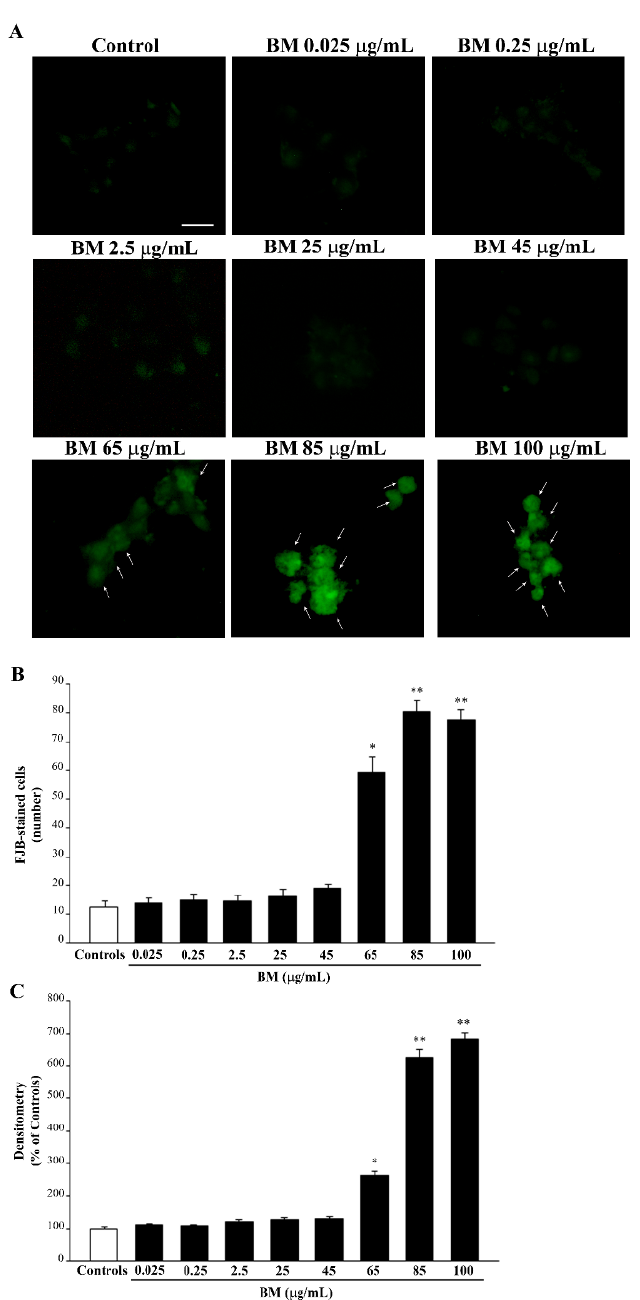
Figure 2. Dose–response of BM on FJB staining. ( A ) Representative pictures of FJB-stained PC12 cells after treatment with increasing doses (from 0.025 µ g/mL up to 100 µ g/mL) of BM for 72 h. Arrows indicate cells intensely stained with FJB. The graphs report the number ( B ) and the optical density ( C ) of FJB fluorescent cells treated with increasing doses of BM (from 0.025 µ g/mL up to 100 µ g/mL). Values are given as ( B ) mean ± S.E.M. of FJB-positive cells and ( C ) mean percentage ± S.E.M. of optical density (assuming controls as 100% density) from three independent experiments. * p < 0.05 compared with controls and BM up to 45 µ g/mL; ** p < 0.05 compared with controls and BM up to 65 µ g/mL. Scale bar = 12 µ m.